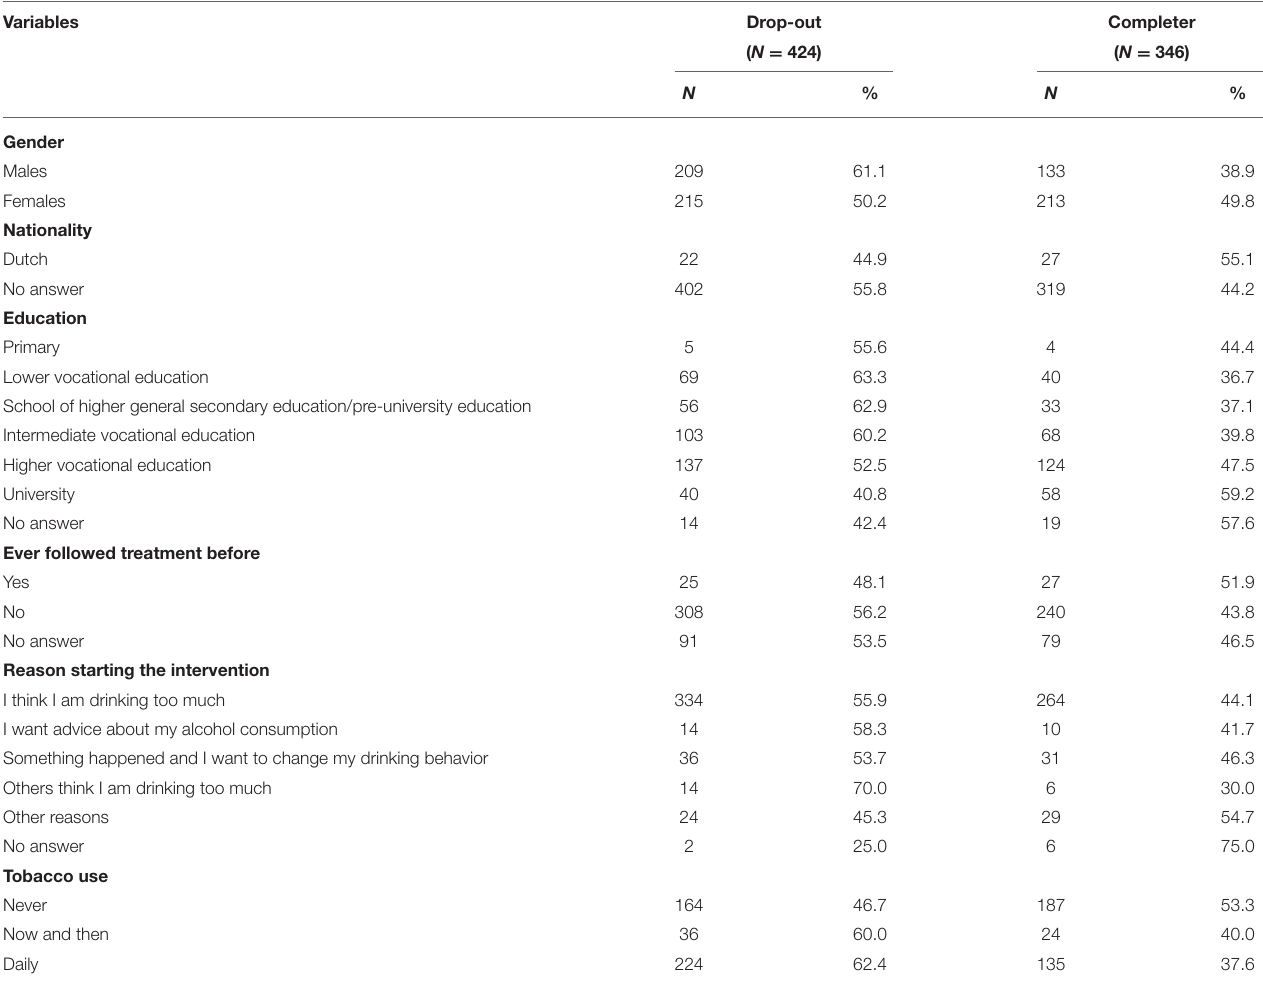
TABLE 2 | Overview of the demographic characteristics in-take questionnaire, split to drop-out and completer.